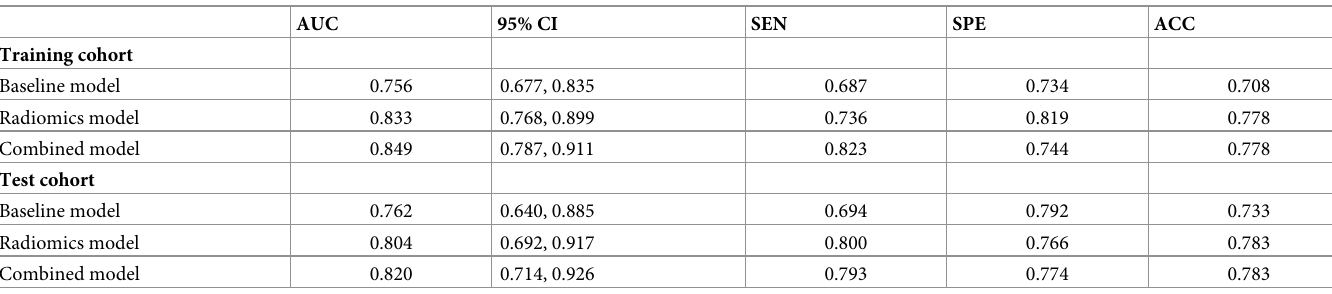
Table 3. Performance of the three prediction models.